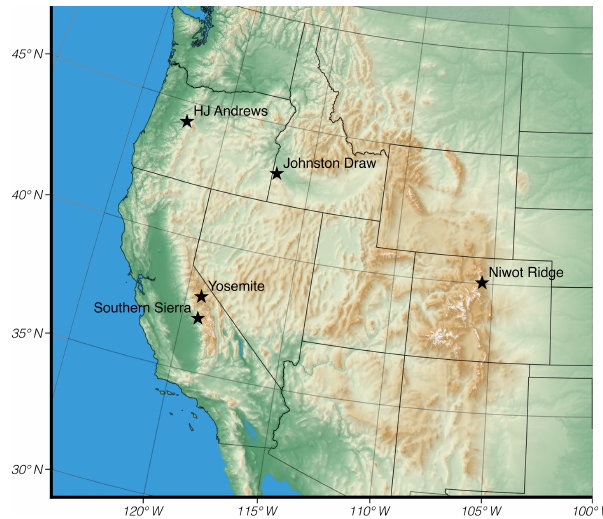
Figure 1. The western United States, showing the five study sites. Details on the stations at each site along with their meteorological characteristics can be found in Sect. 2 and in Table